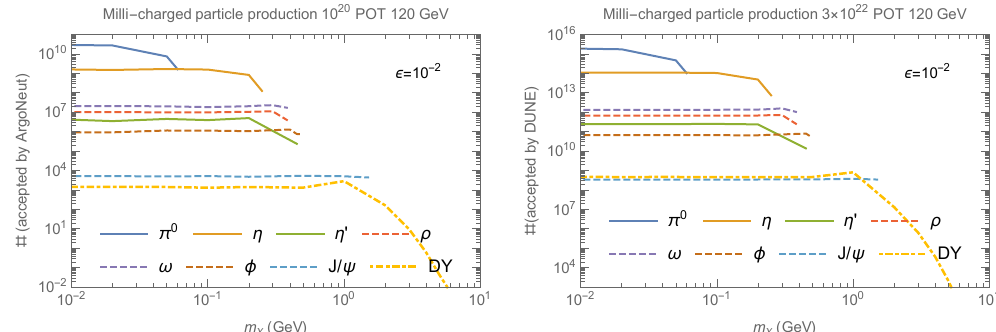
Figure 2 . The number of millicharged particles produced through various sources within Ar- goNeuT’s (left) and DUNE ND’s (right) geometrical acceptance for (cid:15) = 10 (cid:0) 2 , integrated over all mCP energies. We assume 10 20 and 3 (cid:2) 10 22 POT for ArgoNeuT and DUNE ND respectively. The mCP production from scalar mesons (cid:25) , (cid:17) , (cid:17) 0 are shown in solid lines from top-down. The mCP production from vector mesons (cid:26) , ! , (cid:30) , J= are shown in dashed lines from top-down, and the Drell-Yan production is shown in dot-dashed line. The production rate scales as (cid:15) 2